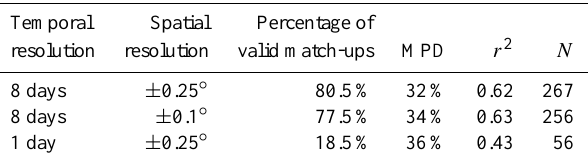
Table 1. Sensitivity study on the impact of the resolution of the satellite extraction window of “HPLC” match-up. The number ( N ) and the percentage of valid match-ups, the median percent differ- ence (MPD) between satellite and in-situ data as well as the deter- mination coefficient ( r 2 ) of the regression performed between two data sets are reported.